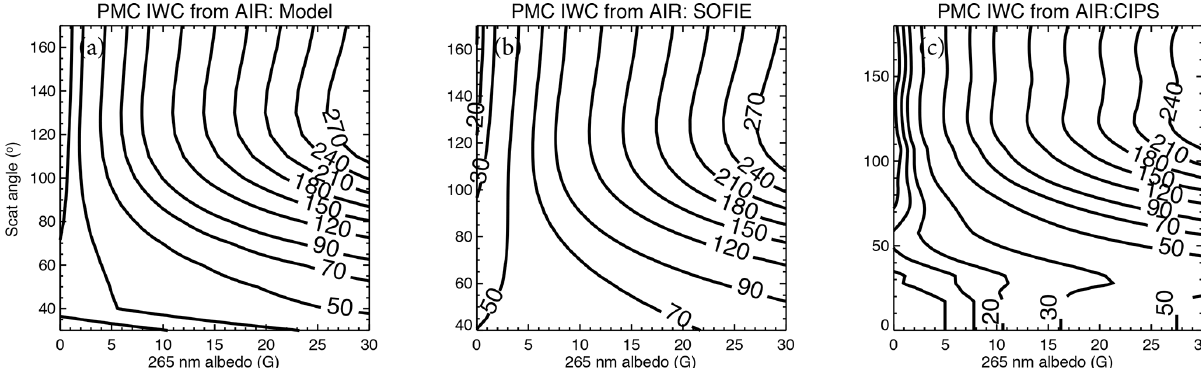
Figure 10. Contour plots of the AIR approximations for IWC versus cloud albedo (G) for the three data sources: (a) model, (b) SOFIE, and (c)